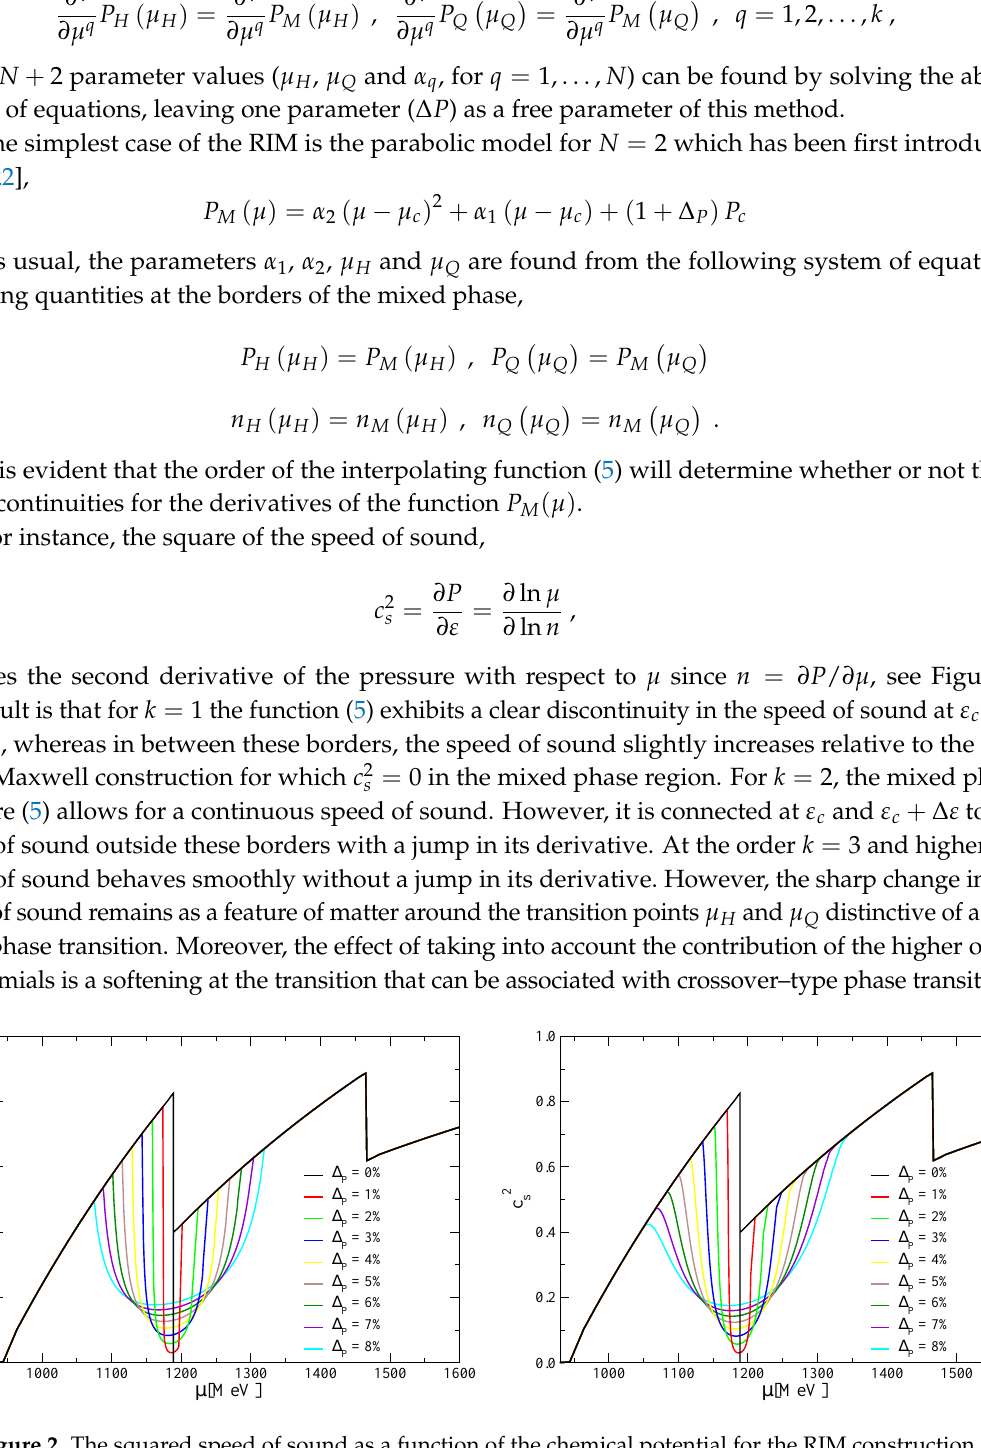
Figure 2. The squared speed of sound as a function of the chemical potential for the RIM construction with k = 2 ( left panel ) and k = 3 ( right panel